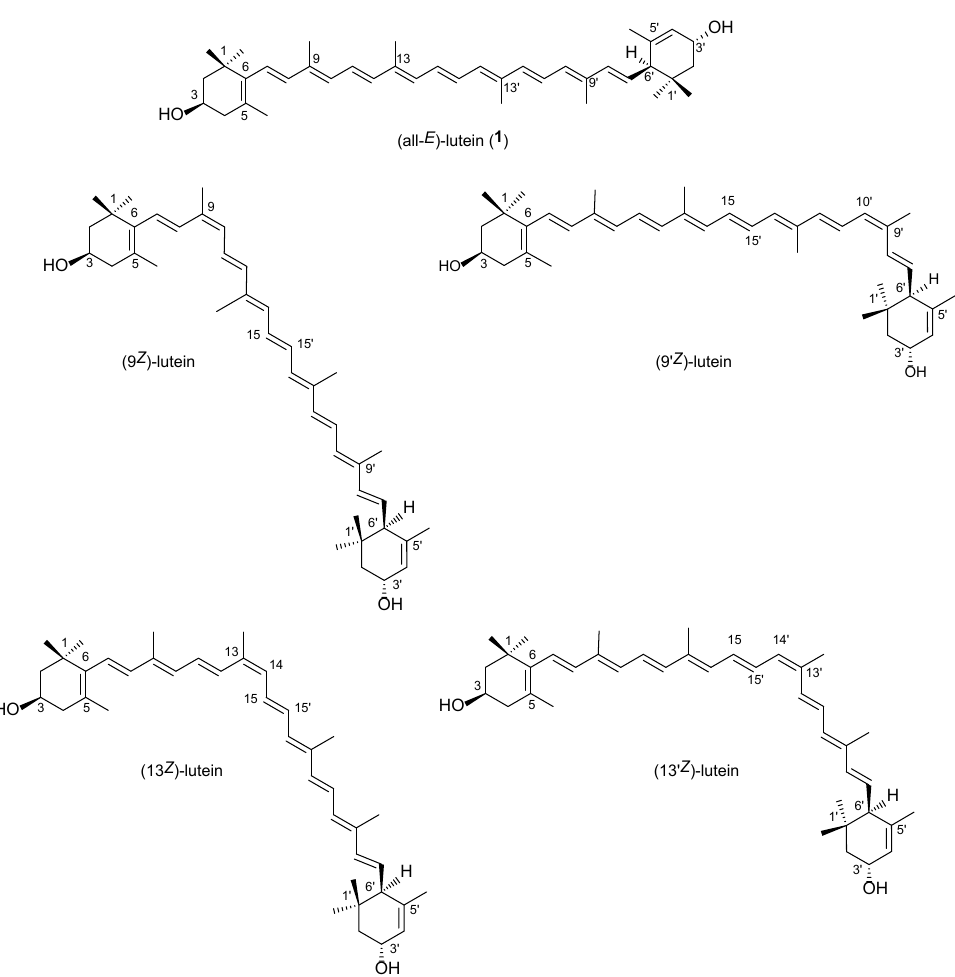
Figure 1. The main geometrical isomers of lutein.